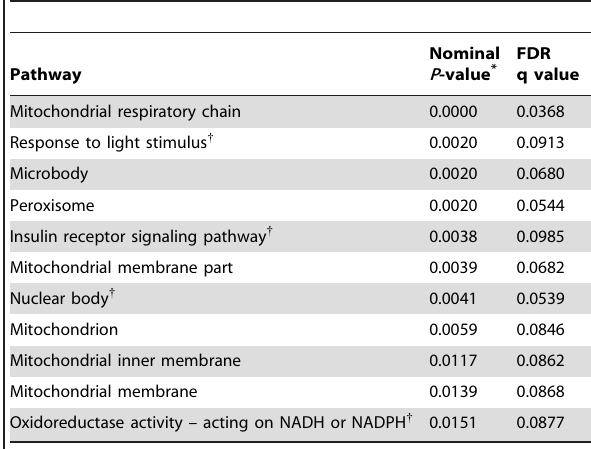
Table 5. GSEA pathways down-regulated due to treatment with FO diet, as compared to control samples.